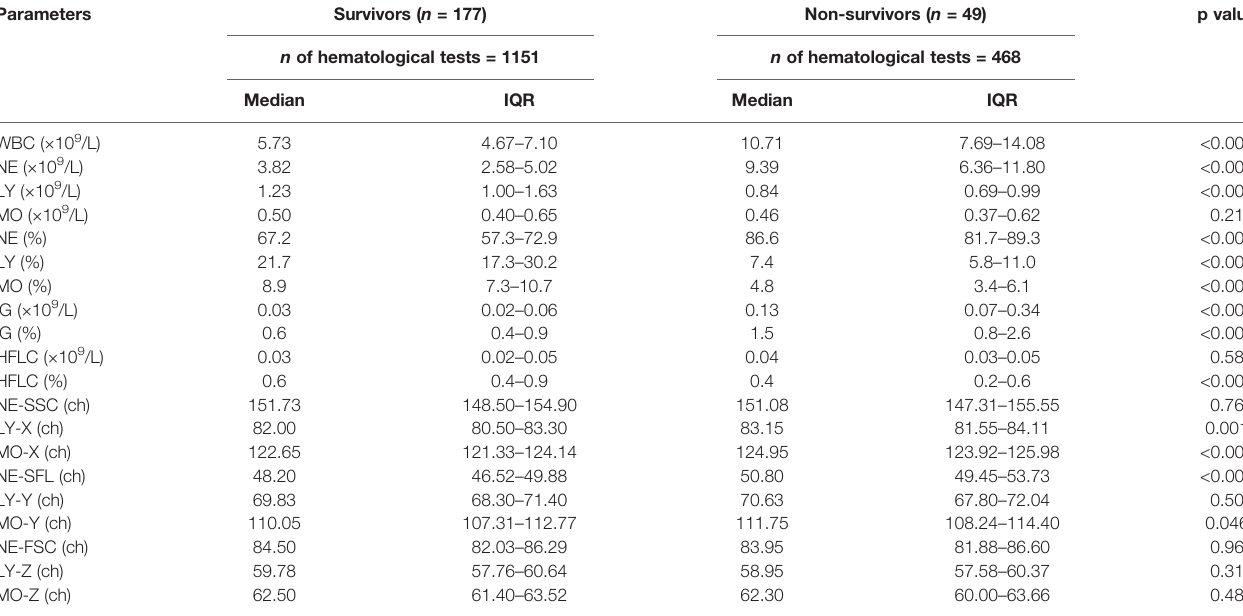
TABLE 2 | Comparison of all leukocyte-derived parameters evaluated in the study according to the outcome of COVID-19 patients in the development cohort.